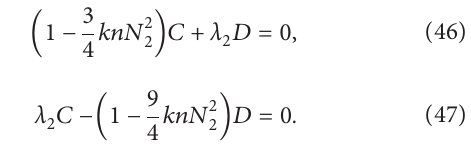
Figure 8: Slow invariant manifold for the case λ